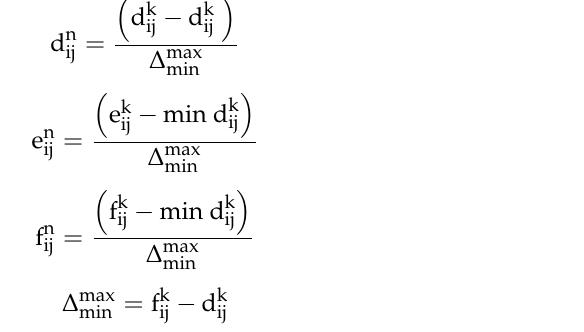
2. Normalized crisp values are computed for the left side and right side, using Equations (12) and (13).